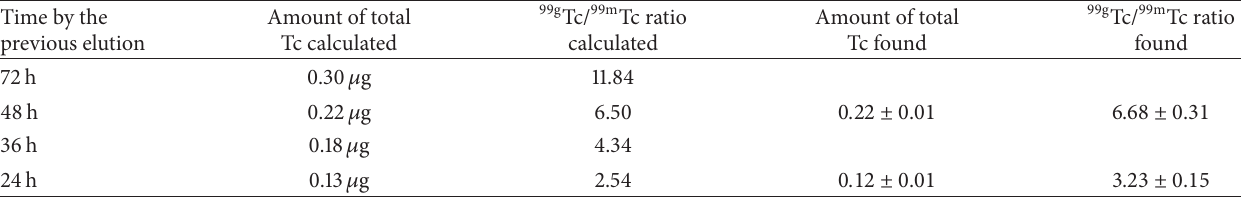
Table 7: Evaluation of total technetium amount in 99m Tc eluates coming from a generator with 99 Mo calibrated activity of 10GBq, at different times by previous